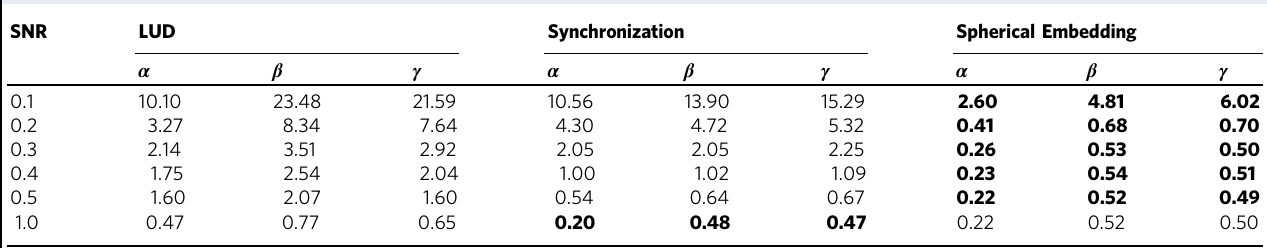
Table 1 Comparison of the RMSEs (in degrees) of the estimated Euler angles produced at different SNR levels by LUD, Synchronization, and the proposed method (Spherical